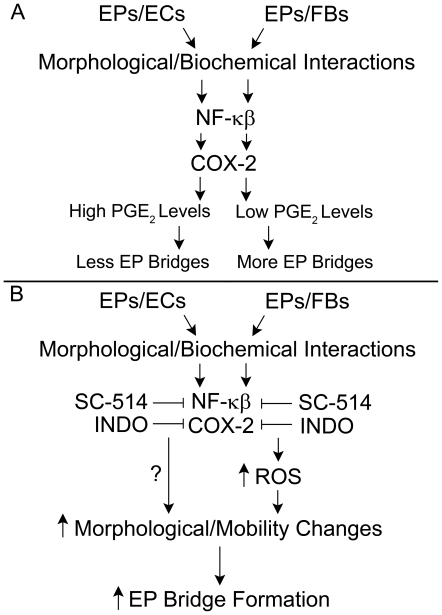
Morphological and biochemical interactions regulate EP bridge formation through mediation of inflammation.
A: Cellular and biochemical interactions between EPs and ECs or FBs may differentially regulate the NF-κβ and COX inflammatory pathways, producing higher levels of PGE2 in EPs/ECs compared to EPs/FBs. PGE2 impedes EP bridge formation and fewer EP bridges are observed in EPs/ECs compared to EPs/FBs. B: Pharmacologic blockade of these inflammatory pathways with SC-514 (an NF-κβ inhibitor) or indomethacin (INDO, a COX inhibitor) increases morphological and mobility changes, leading to increased EP bridge formation in both co-cultures. Inhibition of both NF-κβ and COX pathways in only EPs/FBs may stimulate ROS production and in that manner increase EP bridge formation.